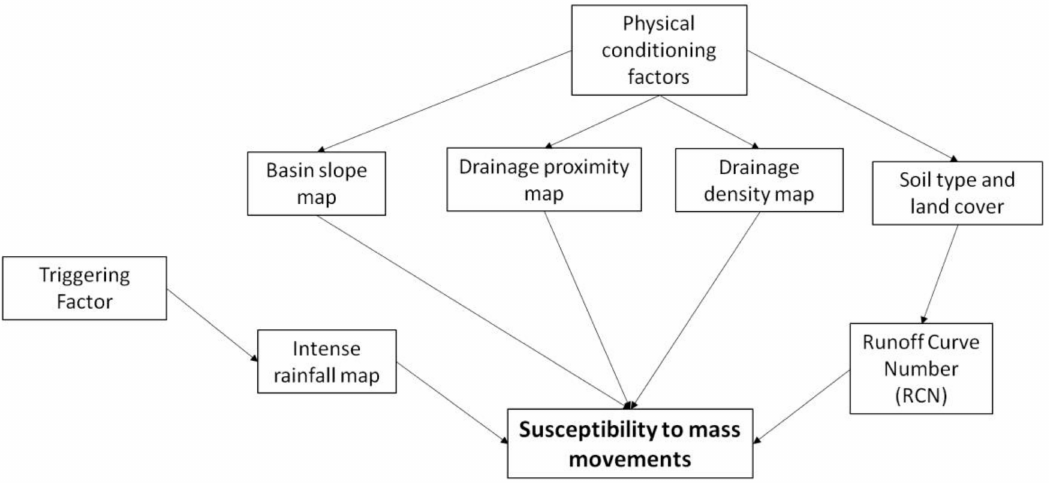
Figure 3. Conceptual scheme of the model for the evaluation of susceptibility to mass movements in